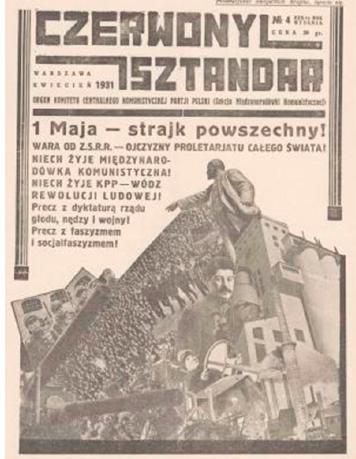
Figure 2. Teresa Ż arnower, front cover of the book The Defense of Warsaw. Polish people in defense of the capital (September 1939) , Format: 15 cm × 22 cm, 1942, courtesy of On Paper Store, Italy.